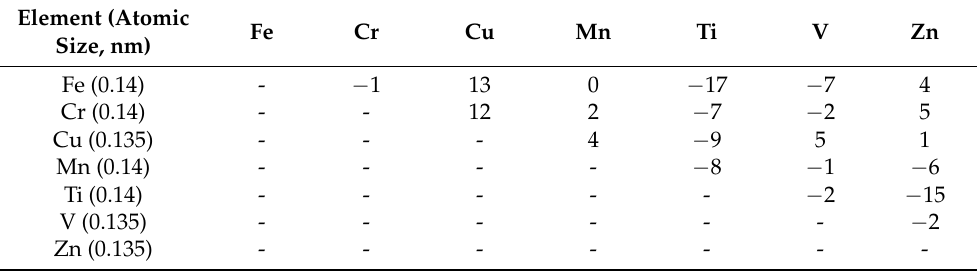
Table 7. Chemical mixing enthalpy ( ∆ H mix alloys determined by Miedema’s approach